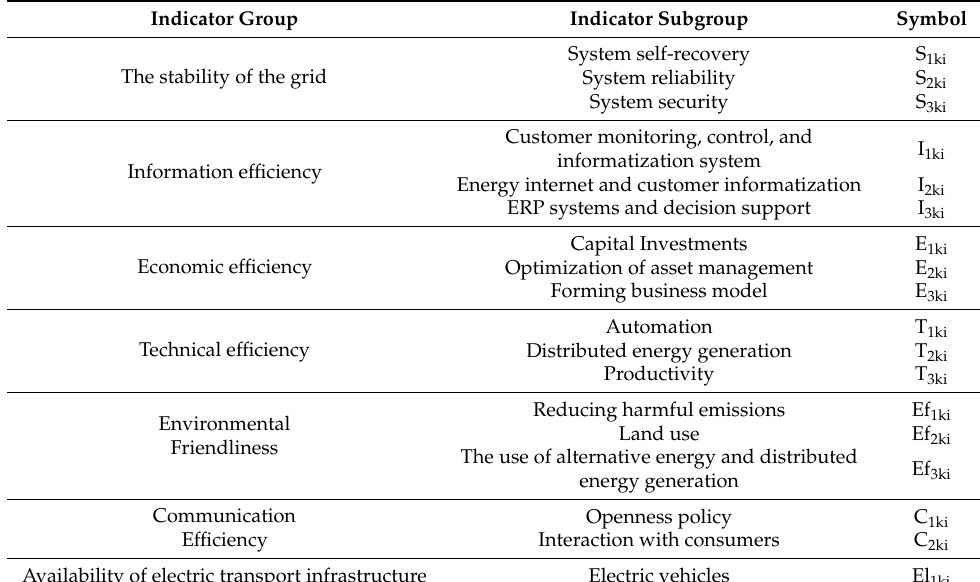
Table 1. The system of indicators for smart grids’